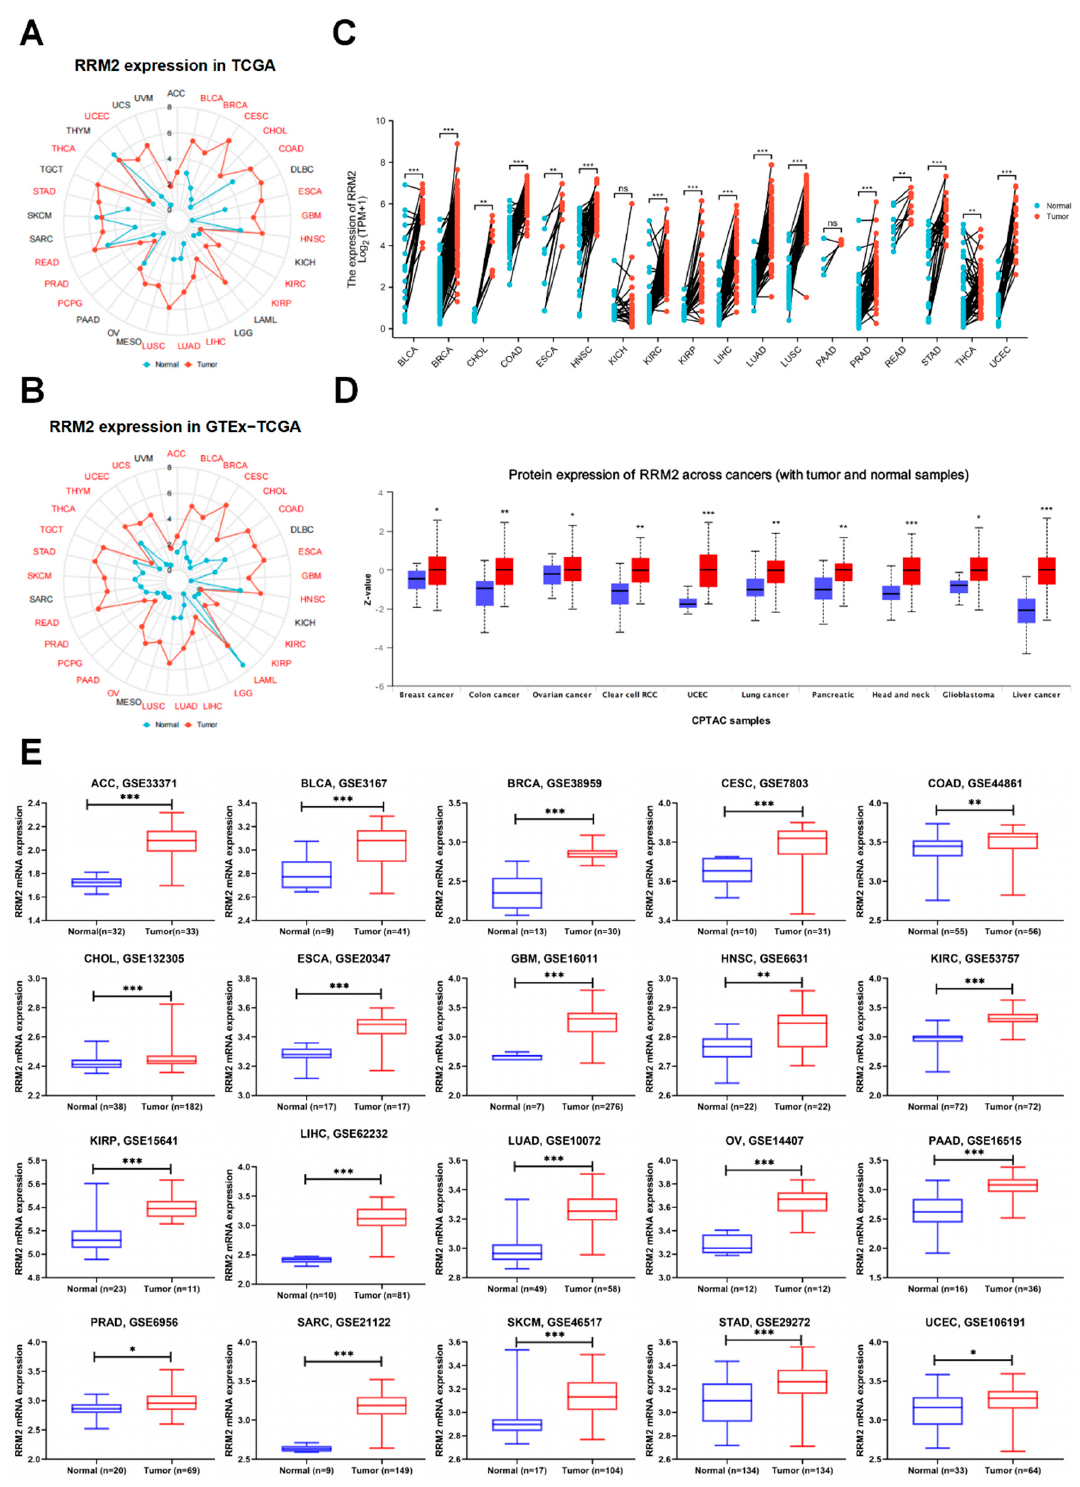
Figure 1. Overexpression of RRM2 in BLCA. ( A , B ) RRM2 mRNA expression in pan-cancer based on TCGA ( A ) and GTEx − TCGA database ( B ) (Red color indicated statistical significance). ( C ) RRM2 mRNA expression in paired tumor and adjacent normal tissues in TCGA database. ( D ) RRM2 protein expression in pan-cancer obtained from UALCAN database (http://ualcan.path.uab.edu/, accessed on 25 February 2022). ( E ) RRM2 mRNA expression in pan-cancer based on GEO database. (* p < 0.05, ** p < 0.01, *** p < 0.001). Moreover, RRM2 protein expression was evaluated in CTPAC samples with UALCAN. RRM2 protein expression increased in BRCA, COAD, OV, KIRC, UCEC,